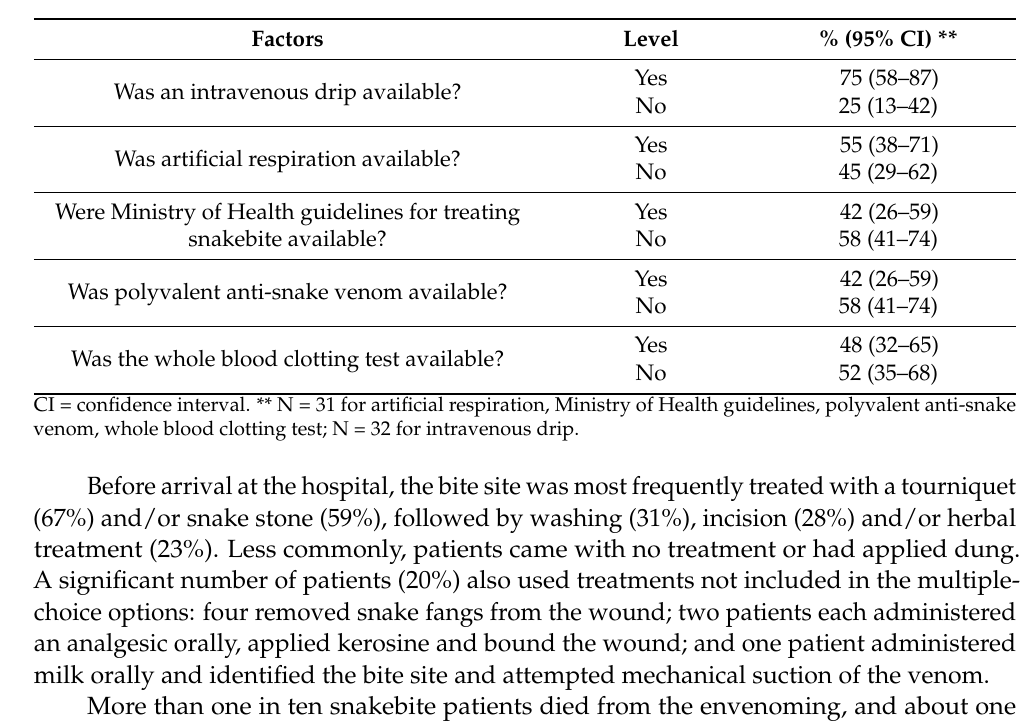
Table 3. Hospital resources for snakebite treatment.